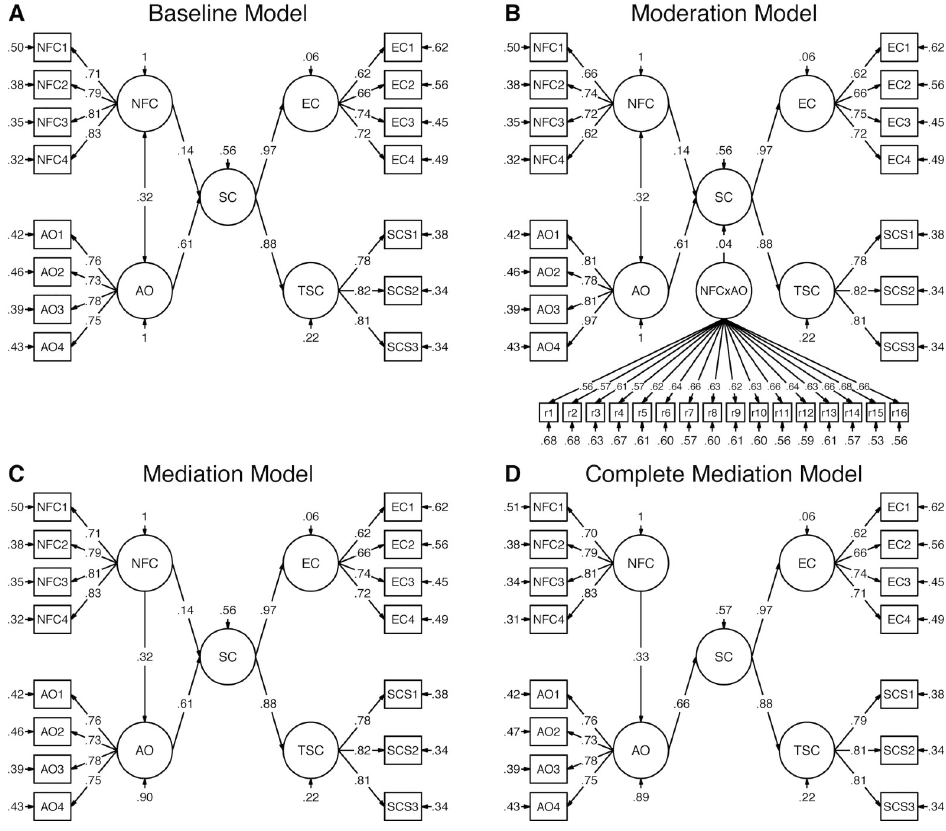
Fig 3. Structural equation models of Need for Cognition and Action Orientation predicting Self-Control.